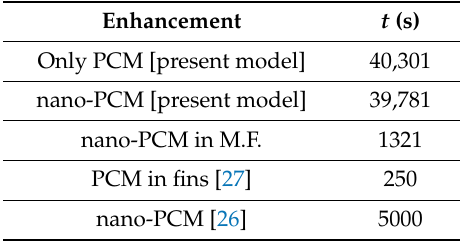
Table 4. Comparison of different enhancement in terms of melting